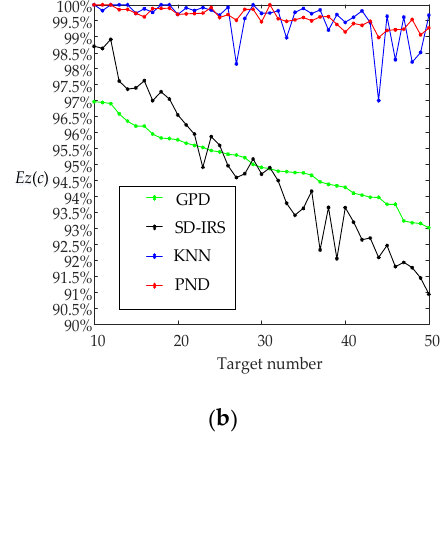
Table 6. The parameter settings for simulation scenario 2.